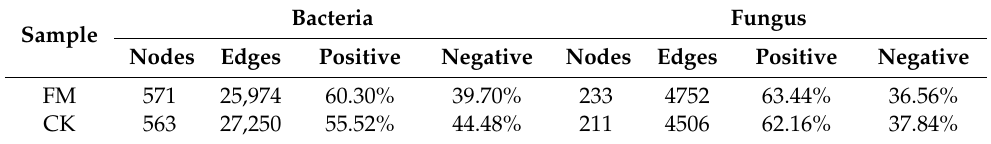
Table 3. Analysis of the co-occurrence network of bacterial and fungal communities.